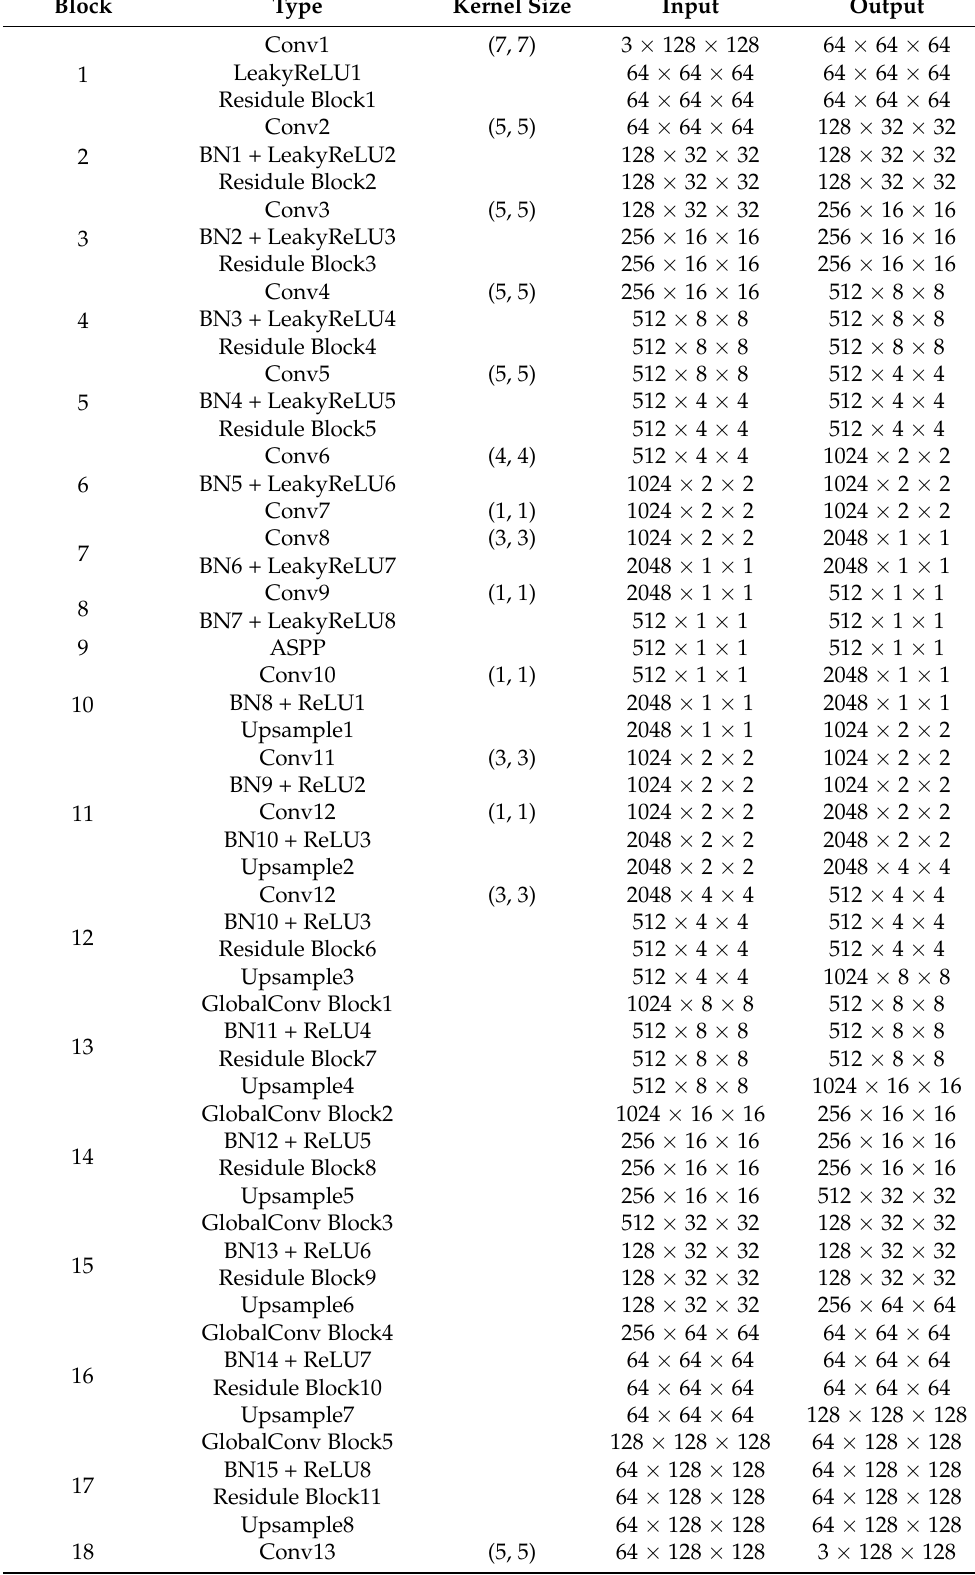
Table 1. The detailed blocks of the proposed